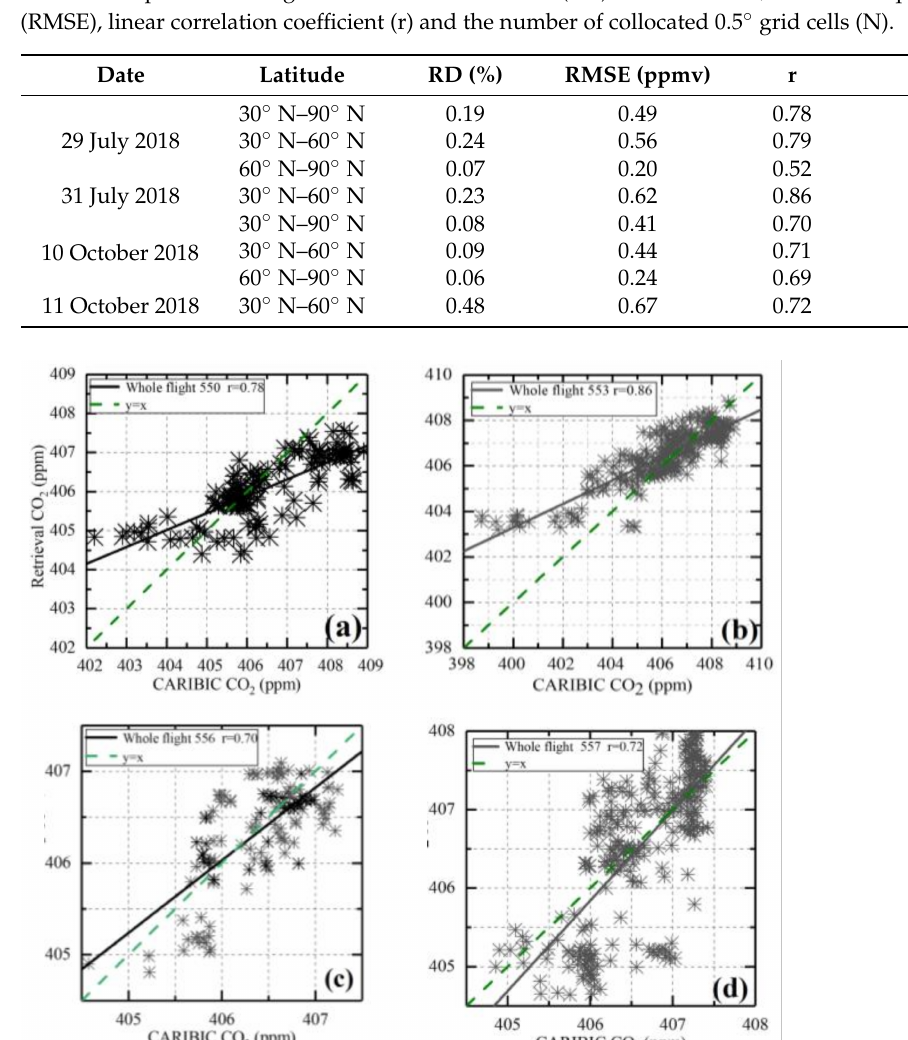
Figure 5. CO 2 comparison between smoothed CARIBIC and CrIS retrievals with the spatial resolution of 0.5 ◦ × 0.5 ◦ ( a ) flight No. 550, ( b ) flight No. 553, ( c ) flight N0. 556, ( d ) flight No. 557. From CARIBIC’s flight trajectory, we can see that the No. 556 and 557 flight paths were mostly over the ocean. Here, we divided the land and ocean according to the surface types and compared the inversion results with the smoothed values. Figure 8 depicts that the correlation of land was higher than that of ocean, while there was no significant difference between RD and RMSE. The number of samples on land and ocean was 524 and 204, respectively. It is possible to speculate that the ocean is affected by the temperature, humidity, surface reflectance, and fewer data points than the land, which results in the low correlation of the inversion results. We also found outliers of low CARIBIC values that were overestimated by CrIS retrievals over land, and conversely, high CARIBIC values that were underestimated by CrIS retrievals over ocean. In addition to the influence of temperature and humidity, it may be related to the insufficient distribution of priori profile samples in marine